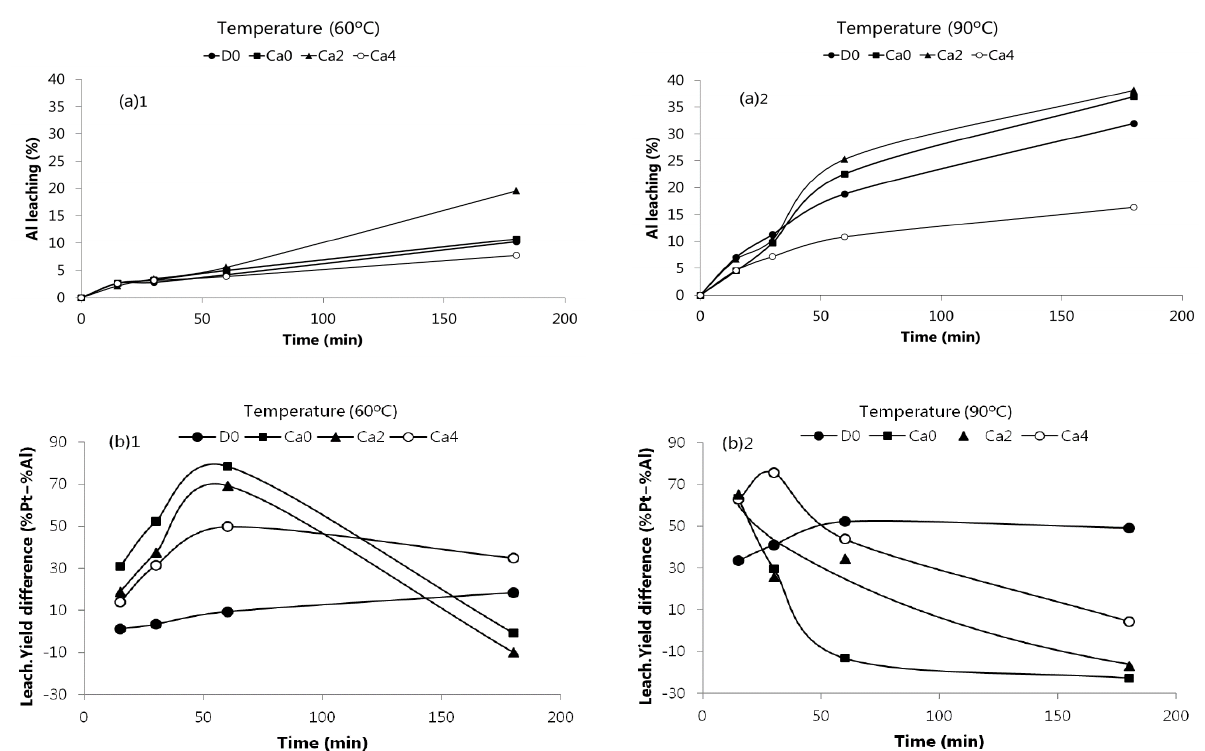
Figure 3. ( a ) Leaching of Al (wt%) at 60 and 90 ◦ C from the SACC; ( b ) Selectivity for Pt against Al, expressed as leaching yields difference